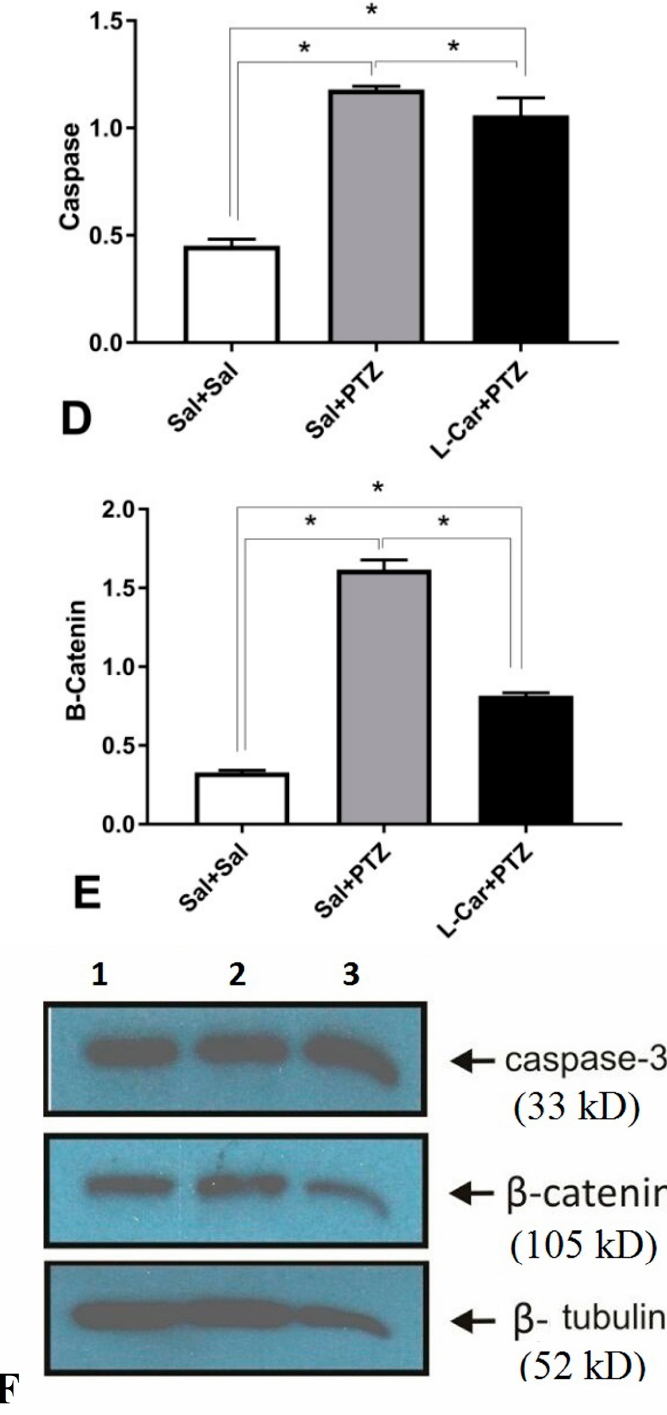
Figure 2. The molecular effects of L -car on oxidants and antioxidants. ( A ) PTZ-treated animals had significantly (*) higher malondialdehyde (MDA) compared to saline controls (*): mean difference = 31.35, 95% CI = 25.52–37.18, p < 0.0001, and L -Car-treated PTZ animals compared to saline controls (*): mean difference = 18.22, 95% CI = 12.39–24.04, p < 0.0001, as well as compared to PTZ-treated animals: mean difference = − 13.13, 95% CI = − 18.96– − 7.307, p < 0.0001, by one-way ANOVA followed by Tukey’s multiple comparisons test, six animals per group. ( B ) Significant difference in catalase enzyme activity (F 2, 15 = 12.76, p = 0.0006) by one-way ANOVA with marked reduction in L -Car-treated